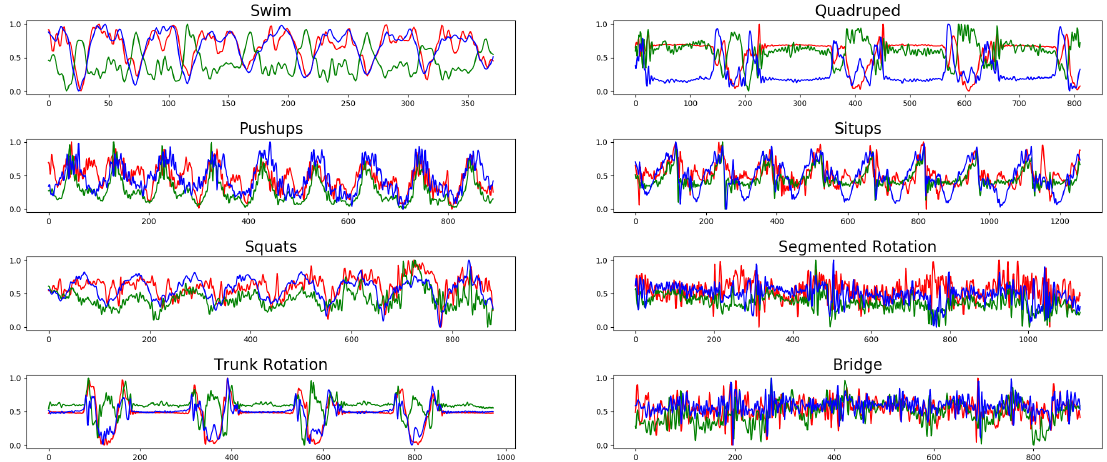
Figure 13. Acceleration data for the eight exercises from an entire sport session from one randomly selected participant. The red, blue and green curves represent the acceleration in x, y, and z directions, respectively. The x-axis is the sample time dimension and y-axis shows the normalized acceleration data. The class segmented rotation and bridge have the least modulation due to the dormant hand